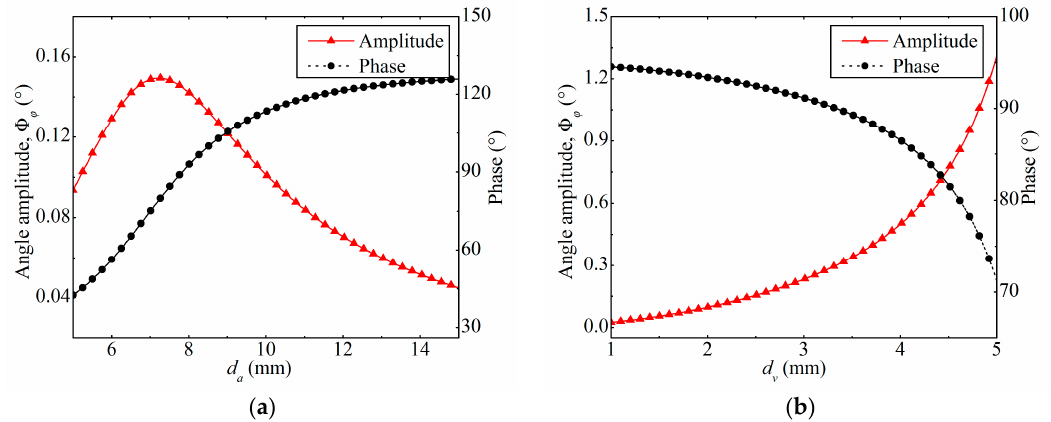
Figure 10. The influence of the action area of the chamber pressure. ( a ) Diameter of the actuator piston ( d a ) and ( b ) diameter of the control valve spool ( d v ).